Question: Give a one-sentence summary of this figure.
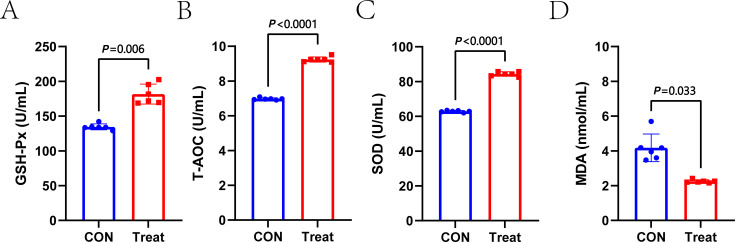
Answer: Effects of supplemental fermented Chinese herbal medicine on serum antioxidant parameters in lamb. Data are presented as mean ± SEM. Group comparisons were analyzed using an independent samples t -test. Bar graphs showing serum antioxidant parameters in lambs with and without fermented Chinese herbal medicine. ( A ) GSH-Px; ( B ) T-AOC; ( C ) SOD; ( D ) MDA. Treatment significantly increased GSH-Px, T-AOC, and SOD levels while decreasing MDA levels, all with statistical significance.